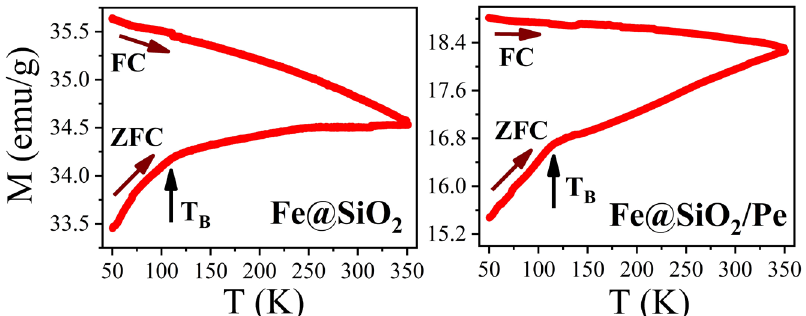
Figure 7. Temperature dependence of magnetization for field cooled (FC) and zero-field cooled (ZFC) nanoparticles under an applied field 500